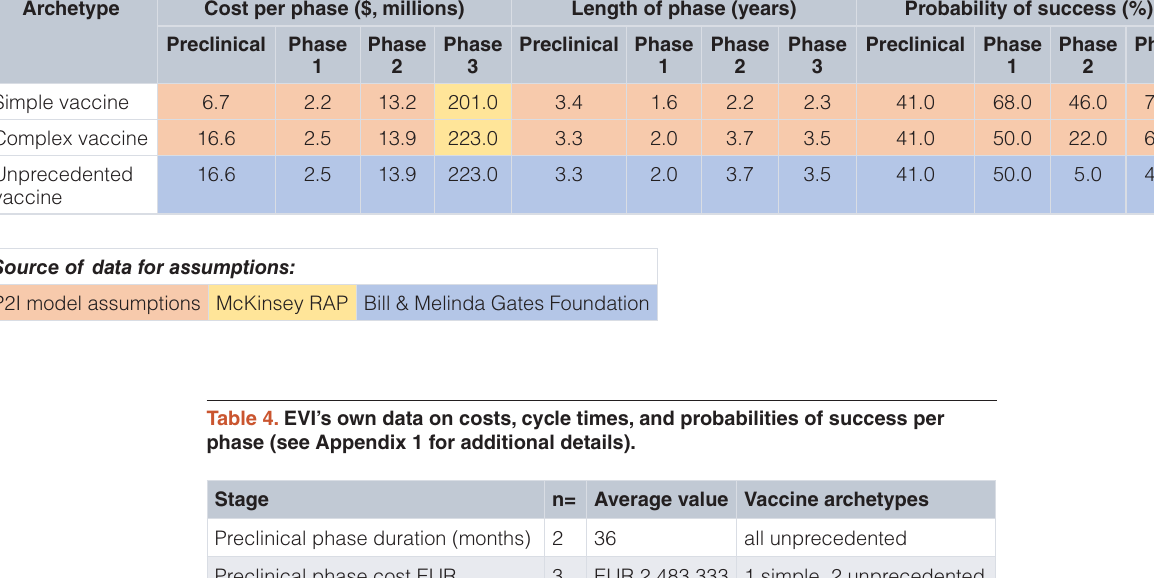
Table 3. Assumptions on costs, cycle times, and probabilities of success per phase for simple, complex, and unprecedented vaccines from the P2I v.2 model (table adapted from reference 2 under a CC-By 4.0 license).